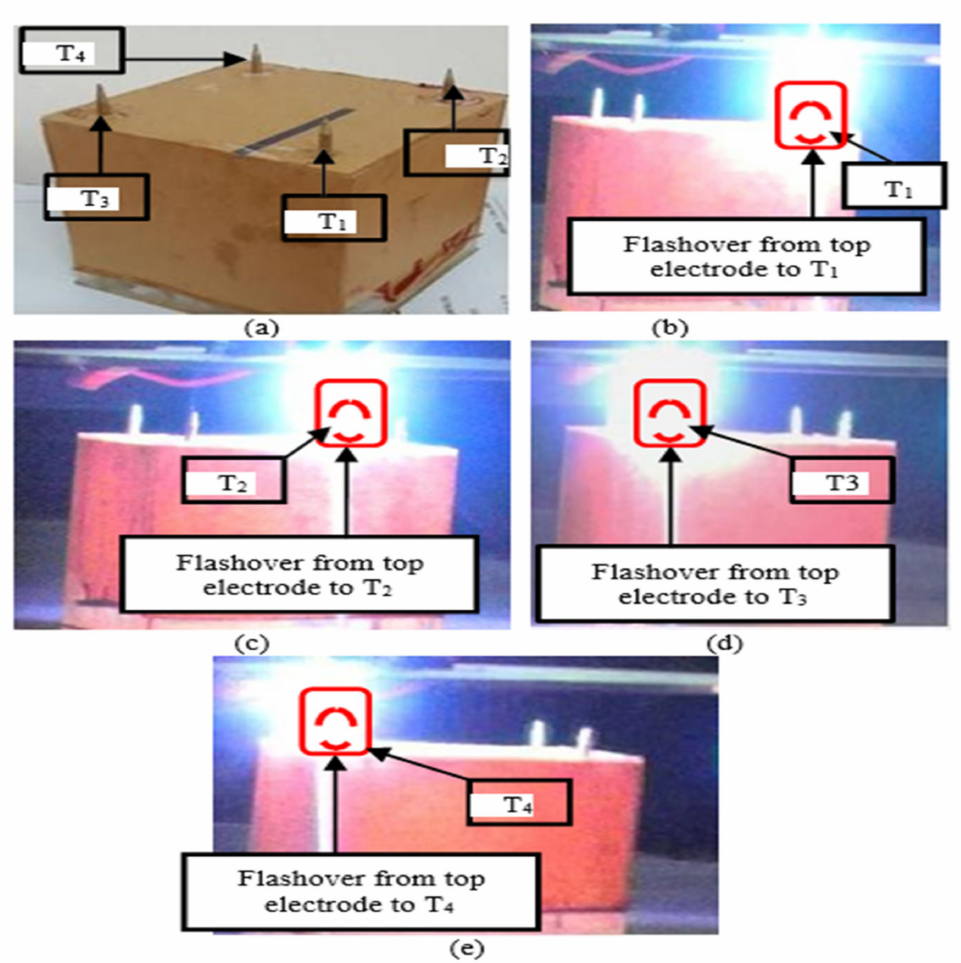
Figure 10. Lightning strike distribution on a square-shape model: ( a ) scaled square shape, ( b ) strike on LAT1, ( c ) strike on LAT2, ( d ) strike on LAT3, ( e ) strike on